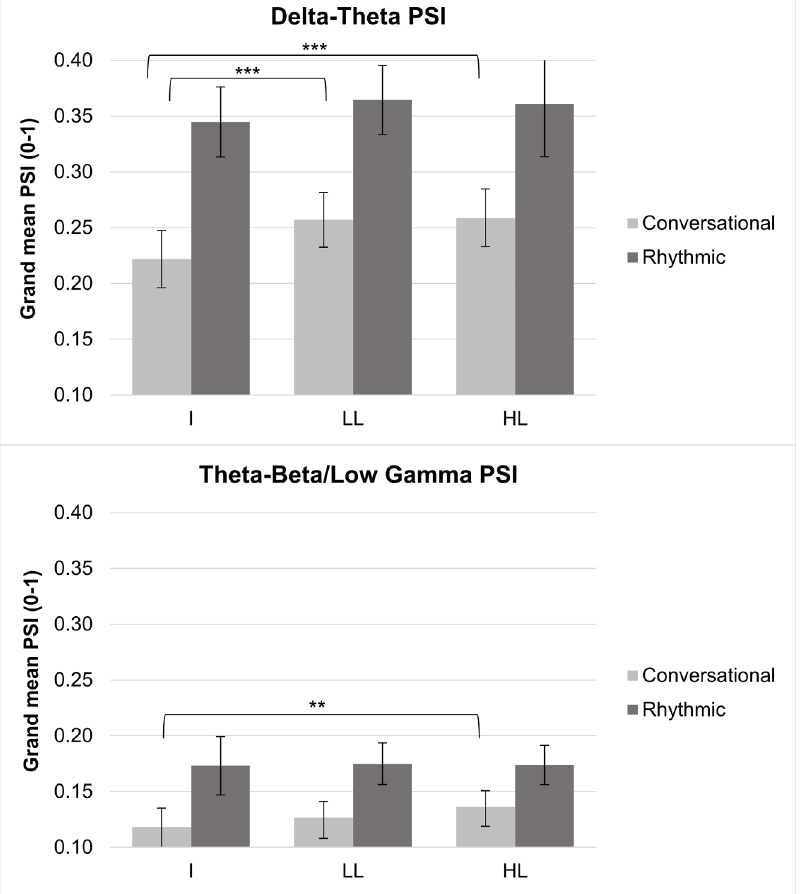
Fig 1. Grand mean PSI values for the two AM band pairs for rhythmic and conversational speech across the 3 literacy groups. I = Illiterates; LL = Low Literates; HL = High Literates. (cid:3) p < .05; (cid:3)(cid:3) p < .01; (cid:3)(cid:3)(cid:3) p < .001.